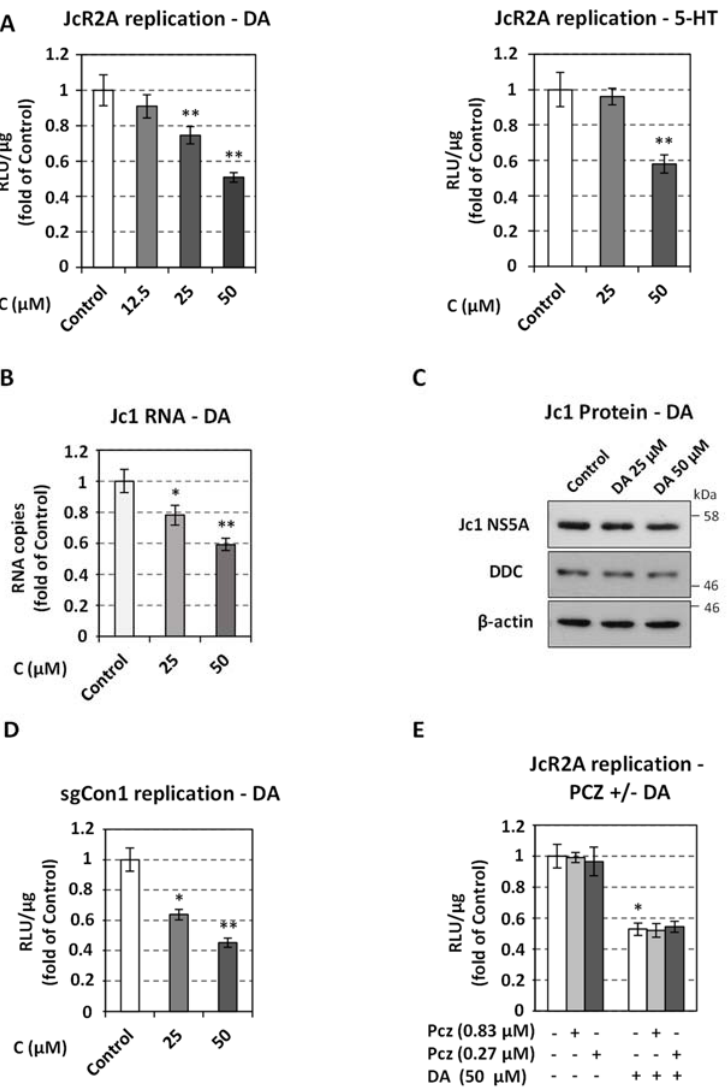
Figure 2. Treatment of HCV-infected cells with DDC products. Huh7.5 cells were inoculated with JcR2A (MOI = 0.5) ( A , E ) or Jc1 (MOI = 1) ( B , C ) for 4 h, and then treated for 72 h, with the indicated concentrations of DA, 5-HT, PCZ or mock-treated (Control). ( A , E ) Virus replication-derived R-Luc activity was determined in cells cultured in the presence or absence of DA (left) or 5-HT (right) and expressed as RLU/ µ g of total protein amount. ( B ) Jc1 positive-strand RNA levels, in cells treated with DA or mock-treated, were quantified by RT-qPCR and YWHAZ mRNA was used for normalization. ( A , B ) Values from control cells were set to one. Bars represent mean values from three independent experiments in triplicate. Error bars indicate standard deviations. * p < 0.01, ** p < 0.001 vs. Control. ( C ) Western blot analysis was performed in lysates of Jc1-infected cells treated for 72 h or mock-treated (Control) with 25 µ M or 50 µ M of DA, using anti-HCV NS5A, anti-DDC, or anti- β -actin antibodies. β -actin was used as loading control. A representative experiment of three independent repetitions is shown. ( D ) Effect of DA on HCV genotype 1b replication. Huh5-2 cells, harboring HCV genotype 1b (Con1) subgenomic replicon, were treated for 72 h with the indicated concentrations of DA, or were mock ‐ treated (Control). Viral RNA replication ‐ derived firefly luciferase activity was determined and expressed as RLU/ μ g of total protein. Values from control cells were set to one. ( Ε ) Combinatory effect of DA and PCZ on JcR2A replication. Values from infected mock ‐ treated cells were set to one. (D ‐ E) Bars represent mean values from three independent experiments in triplicate. Error bars indicate standard deviations. * p < 0.01, ** p < 0.001 vs. Control.